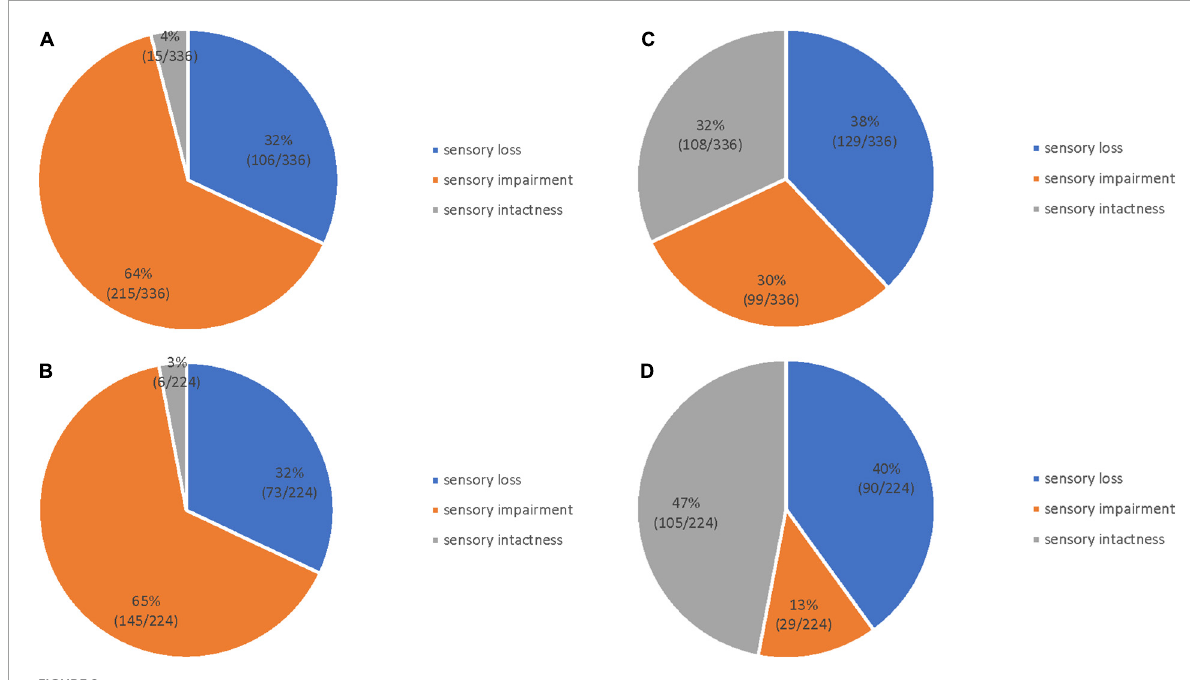
FIGURE2 Sensory dysfunction distribution in 112 patients with stroke. Light touch sensation in the finger (A) and palm (B) regions; 2-PD in the finger (C) and palm (D)